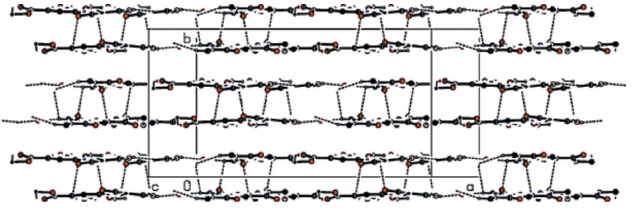
Figure 4 A view of the projection on the ab plane showing the contacts between layers.